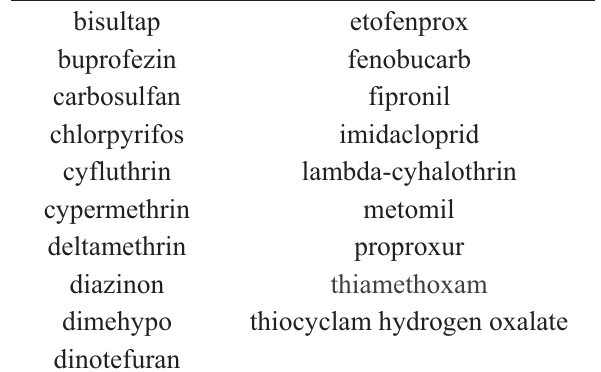
Table 1. Partial list of pesticides being used by Rice Farmers in Central Java in